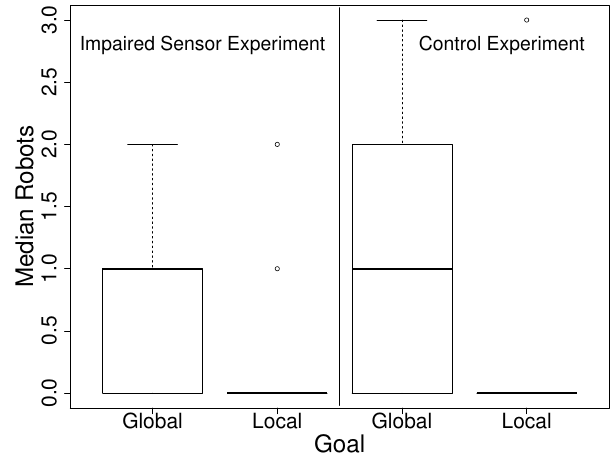
Figure 8: Median number of robots in the two areas. Left: Impaired sensor experiment with 3 fully func- tional and 7 impaired robots. Right: Control exper- iment with 3 fully functional robots. There are no significant differences. Significances are tested with the Wilcoxon-Test ( global optimum against local op- timum ) and the U-Test (optimum of one experiment against the same optimum of another experiment) with p < 0 . 05